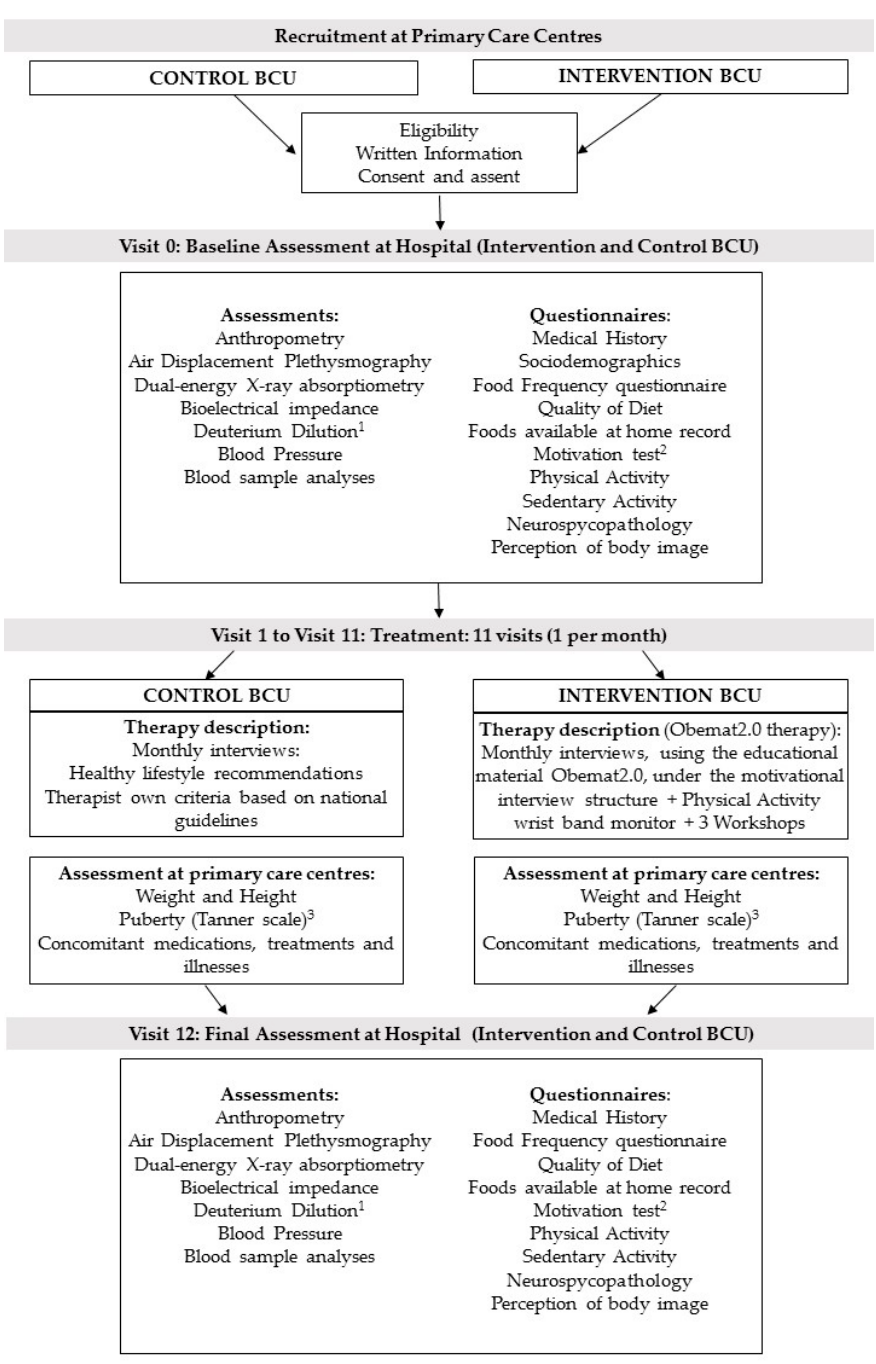
Figure 2. Flow diagram of recruitment, assessment per visit, and intervention. BCU: Basic Care Units; 1 Deuterium dilution analysis in a subsample; 2 Motivation test only in the intervention